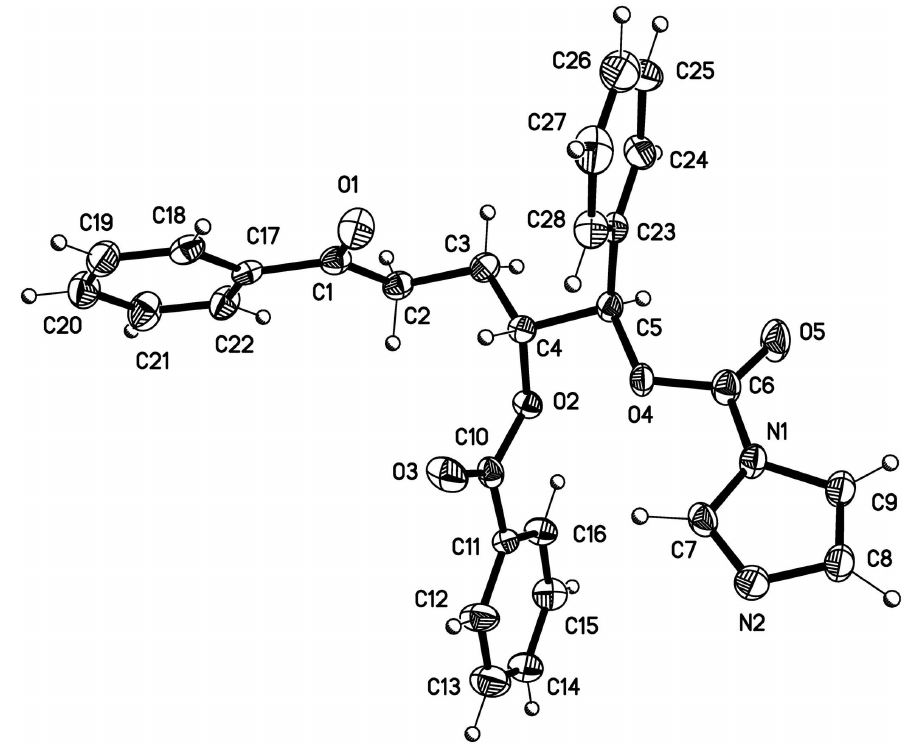
Figure 1 Molecular structure with displacement parameters drawn at the 30% probability level for non-H